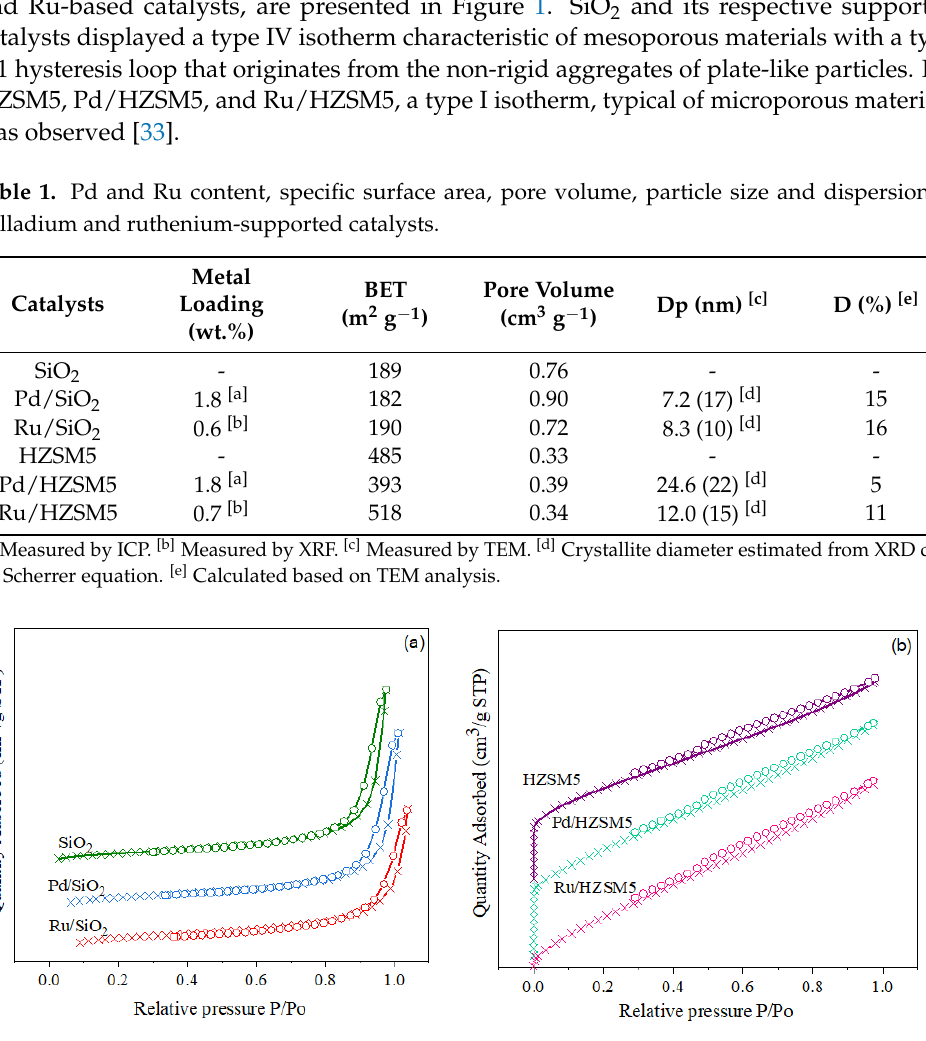
Figure 1. N 2 adsorption–desorption isotherms of ( a ) SiO 2 , Pd/SiO 2 , and Ru/SiO 2 ; ( b ), HZSM5, Pd/HZSM5, and Ru/HZSM5.